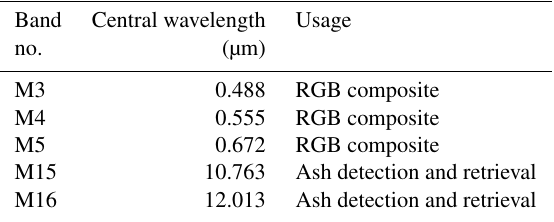
Table 1. VIIRS bands used in this study. Further information is available from https://www.star.nesdis.noaa.gov/smcd/spb/nsun/